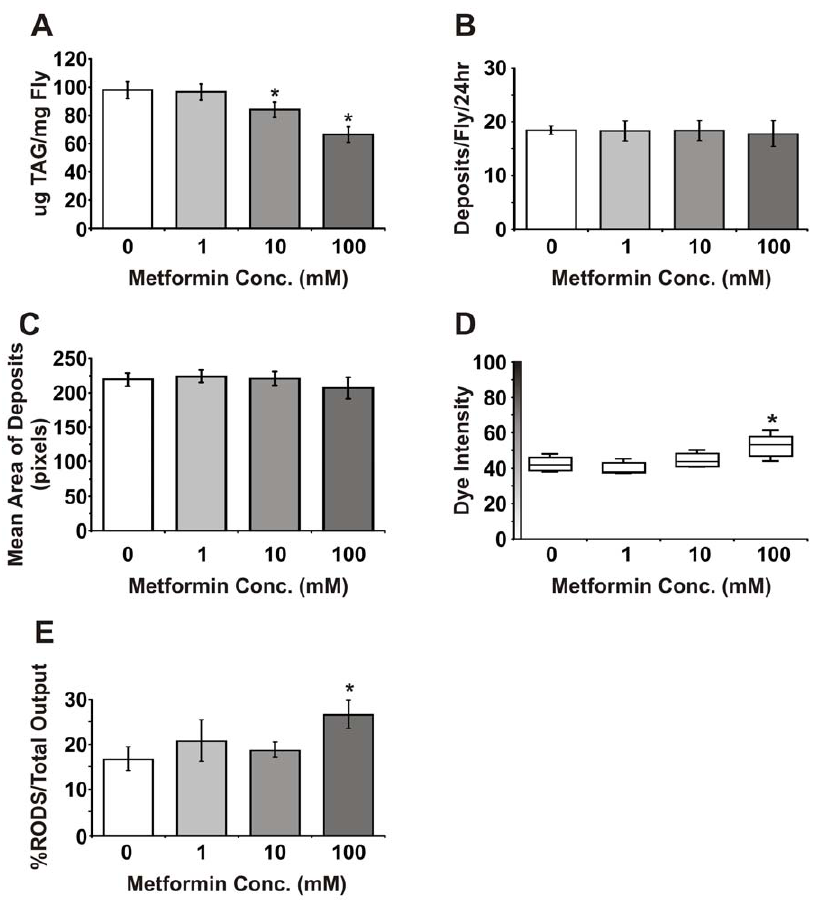
Figure 4. Metformin reduces lipid stores and causes intestinal fluid imbalance. ( A ) Quantitation of triacylglycerides (TAGs) in flies treated with 0 mM, 1 mM, 10 mM and 100 mM metformin for 7 days. TAG levels decrease with increasing metformin concentration with significantly lower levels in the 10 mM and 100 mM metformin groups compared to untreated controls ( P , 0.05, n=10 (2 flies per replicate)). ( B ) Metformin treatment of female flies does not affect the number of fecal deposits produced per fly over a 24 hour period ( P . 0.05 , Wilcoxen test, n=5 (5 flies per replicate)). ( C ) Metformin treatment of female flies does not affect the size of fecal deposits as measured by the mean area of deposits ( P . 0.05 , Wilcoxen test, n=5 (5 flies per replicate)). ( D ) Female flies fed with 100 mM metformin produce more concentrated fecal deposits as measured by increased average dye intensity ( P , 0.05, Wilcoxen test, n=5 (5 flies per replicate)). ( E ) Female flies fed with 100 mM metformin produce more RODs as a percentage of their total excreta output ( P , 0.05, Wilcoxen test, n=5 (5 flies per